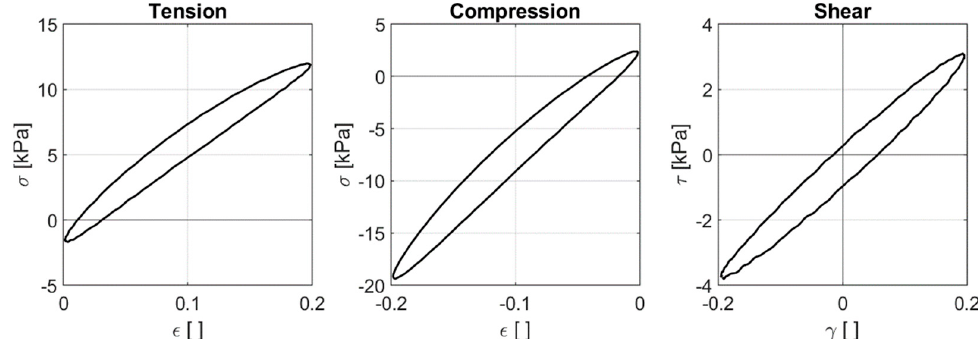
( c ) Figure A1. Specimen during the characterization test. ( a ) Tension. ( b ) Compression. ( c ) Shear.